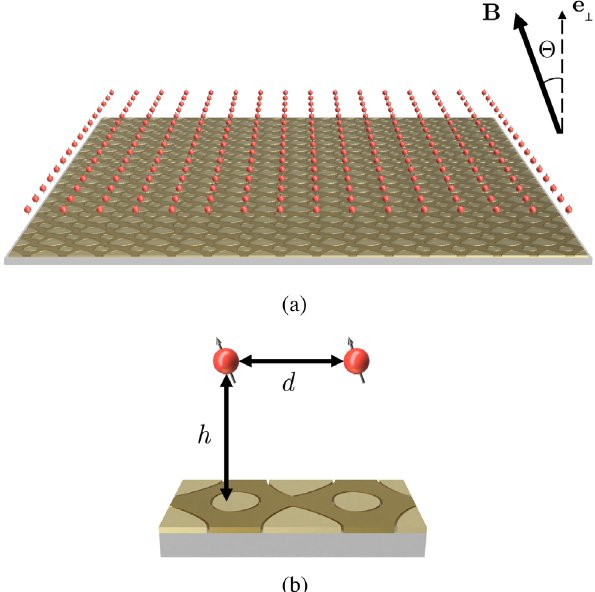
FIG. 1. Proposed array of Penning microtraps. The magnetic field B makes an angle Θ with e ⊥ , the vector normal to the lattice plane in which all of the ions lie. The ion separation is given by the electrode pattern. The critical parameter for the ion-ion interaction is the separation of neighboring sites d , while the distance from the surface h strongly affects the level of noise from fluctuating electric fields